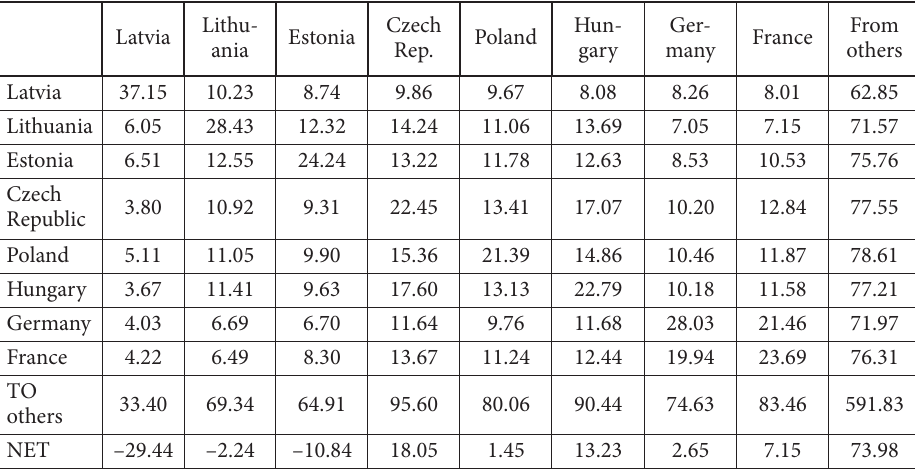
Table 4. Spillover table (Results obtained by the